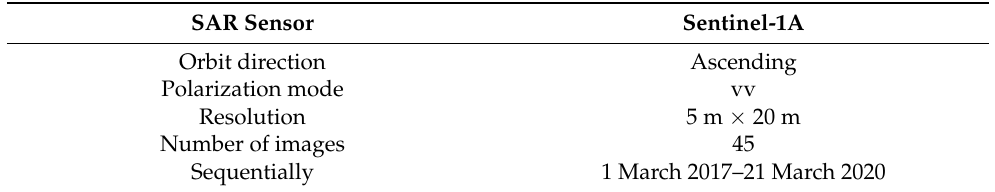
Table 1. Sentinel-1A data